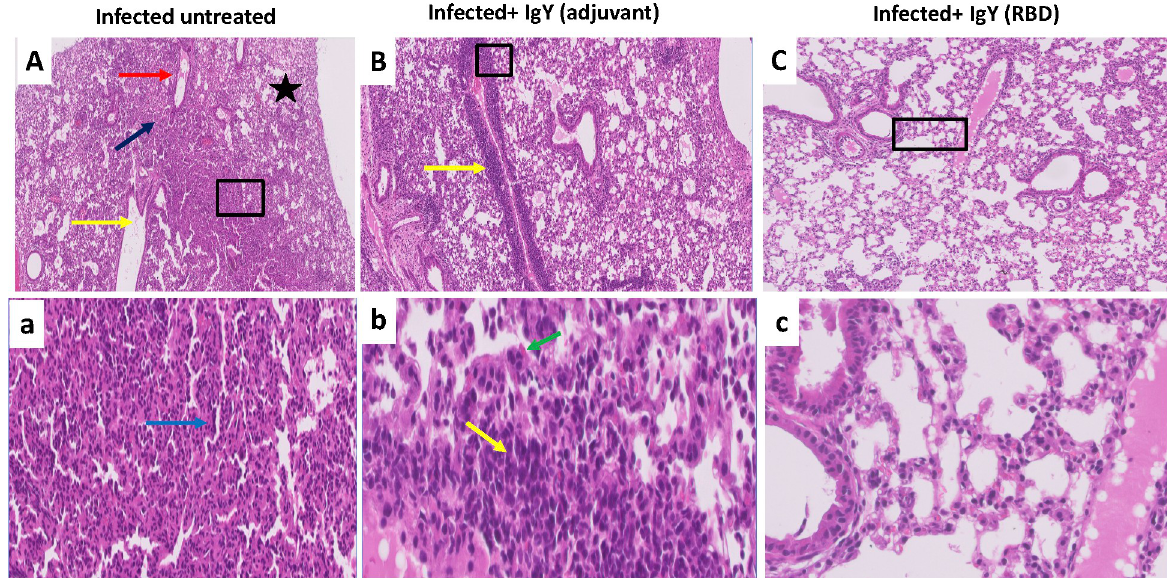
Fig 6. (A and a) Histopathology of the lungs of Ad5-hACE2-transduced mice on day 6 after infection with SARS-CoV-2, showing characteristic bronchioalveolar interstitial pneumonitis with marked alveolar changes represented by alveolar wall thickening due to mononuclear cells infiltration, alveolar pneumocytes type 2 hypertrophic changes and occasionally associated alveolar wall hyalinization (blue arrow). Large number of the alveoli was involved with complete or partial obstruction and presence of some emphysematous alveoli (black star). Some bronchioles appear dilated with presence of exudative fluid in their lumina (yellow arrow). Some blood vessels show partial destruction of their walls with fluid and erythrocytic agglutination (red arrow). (B and b) a perivascular delayed hypersensitive lympho-plasmacytic aggregates with partial vascular wall destruction (yellow arrow) together with moderate alveolitis and alveolar wall thickening and or hyalinization due to pneumocytes hypertrophy and activated alveolar macrophages (green arrow). Some alveoli showed intraluminal aggregates of nonnuclear cells. (C and c), showing apparently normal lung tissue with preserved healthy bronchial tree, alveolar ducts, alveoli besides vascular and stromal structures. Scale bars: 200 μ m (upper row) and 50 μ m (lower